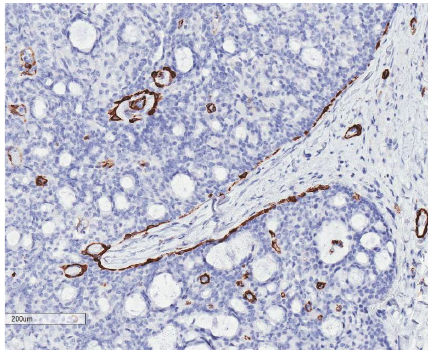
Figure6:Smoothmusclemyosinheavychain(SMMHC)highlights the myoepithelial cells around the